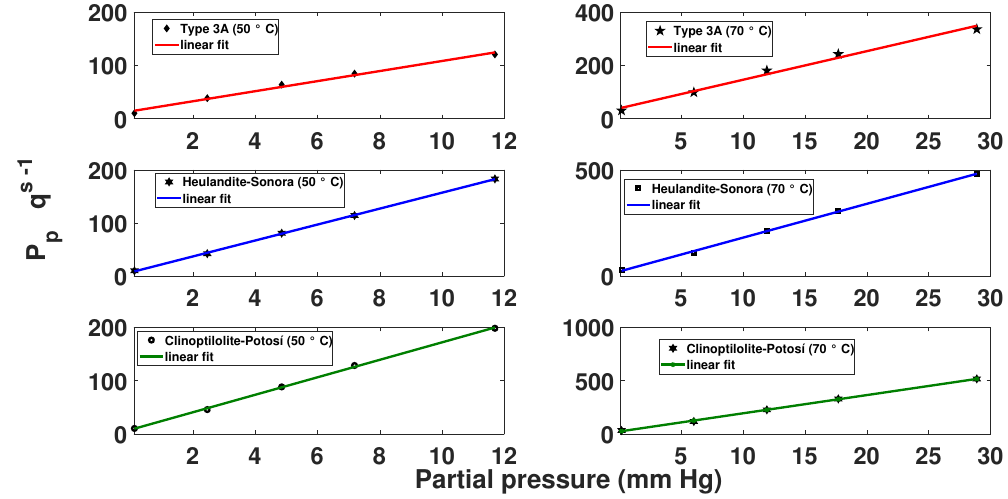
Figure 5. Linearized Langmuir isotherm for the H 2 O / C 2 H 5 OH